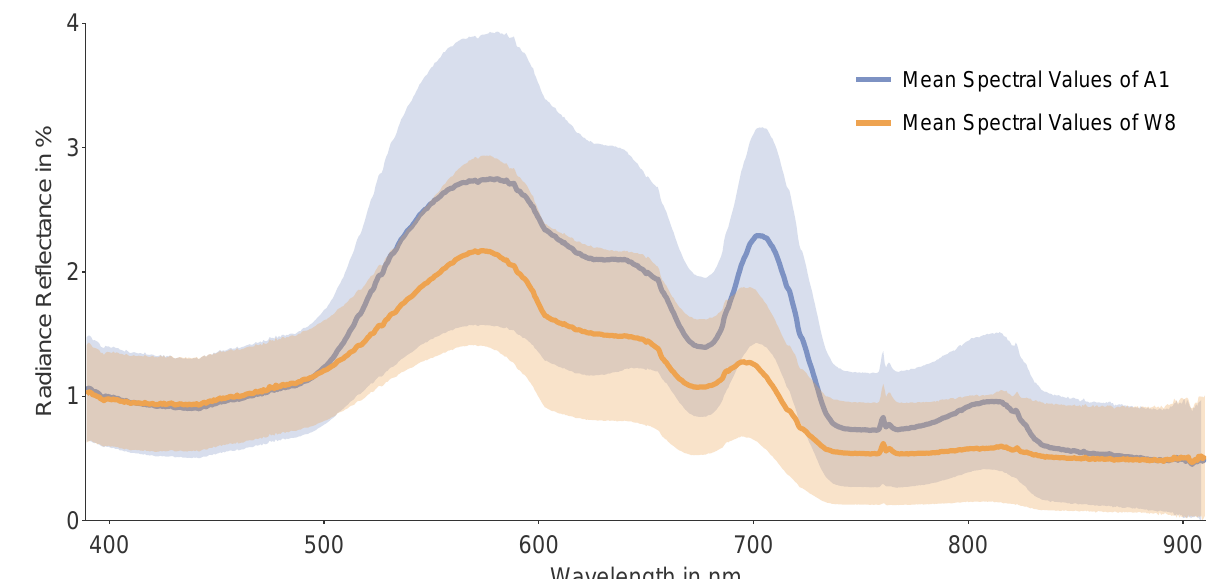
Figure 2. Visualization of the spectral data of the two SpecWa water bodies [43]. The solid lines refer to the mean of the waterbodies A1 (blue) and W8 (orange). The brighter area represents the respective standard deviations. In the SpecWa dataset, the radiance reflectance is the normalized ratio between the water leaving radiance combined with the surface reflectance and the incoming irradiance. The corresponding chlorophyll a concentrations and information are given in Figure 1 and Table